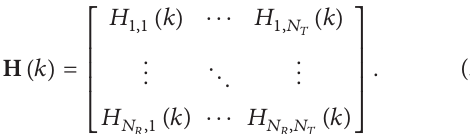
̂𝑋| 2 /̂𝜏) exp (−|𝑋 − ̂𝑋 and variance